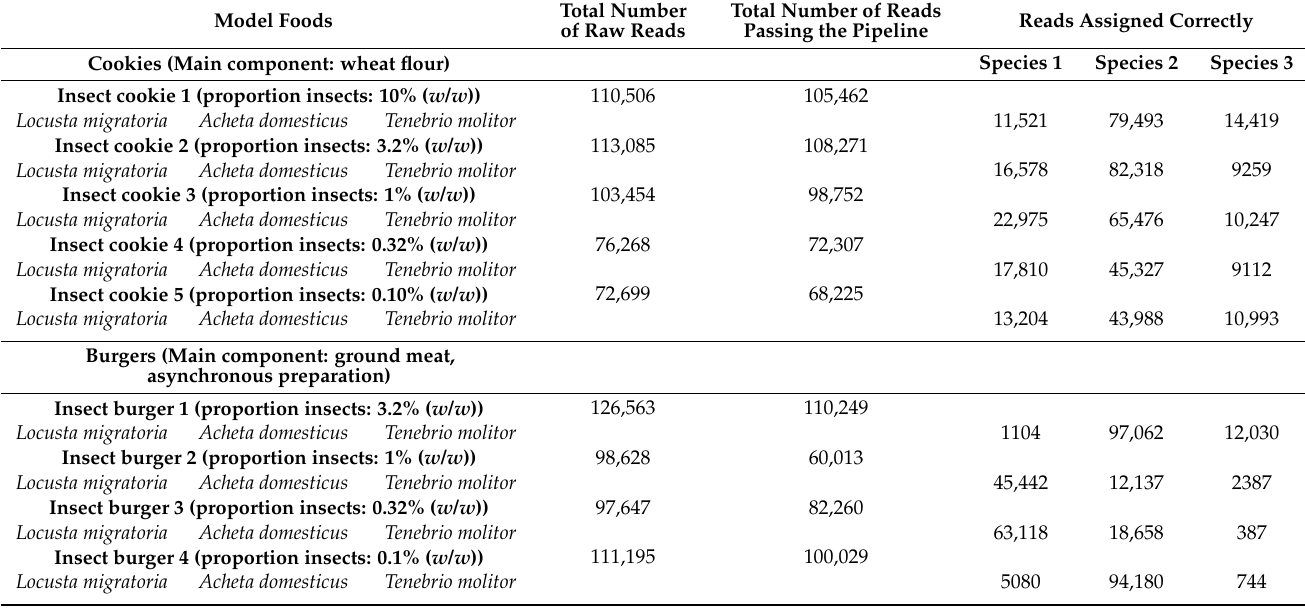
Table 4. Results obtained from model foods representing three insects of interest. Numbers are average values ( n = 2, two sequencing runs, one